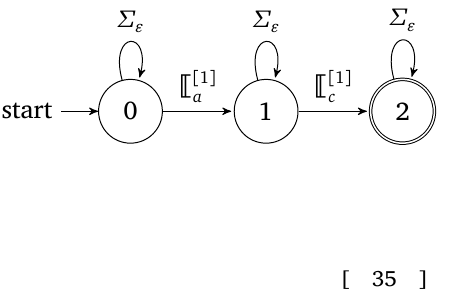
Figure 6: Deterministic FSA M h , ac that recognises R h , ac (cf. Example